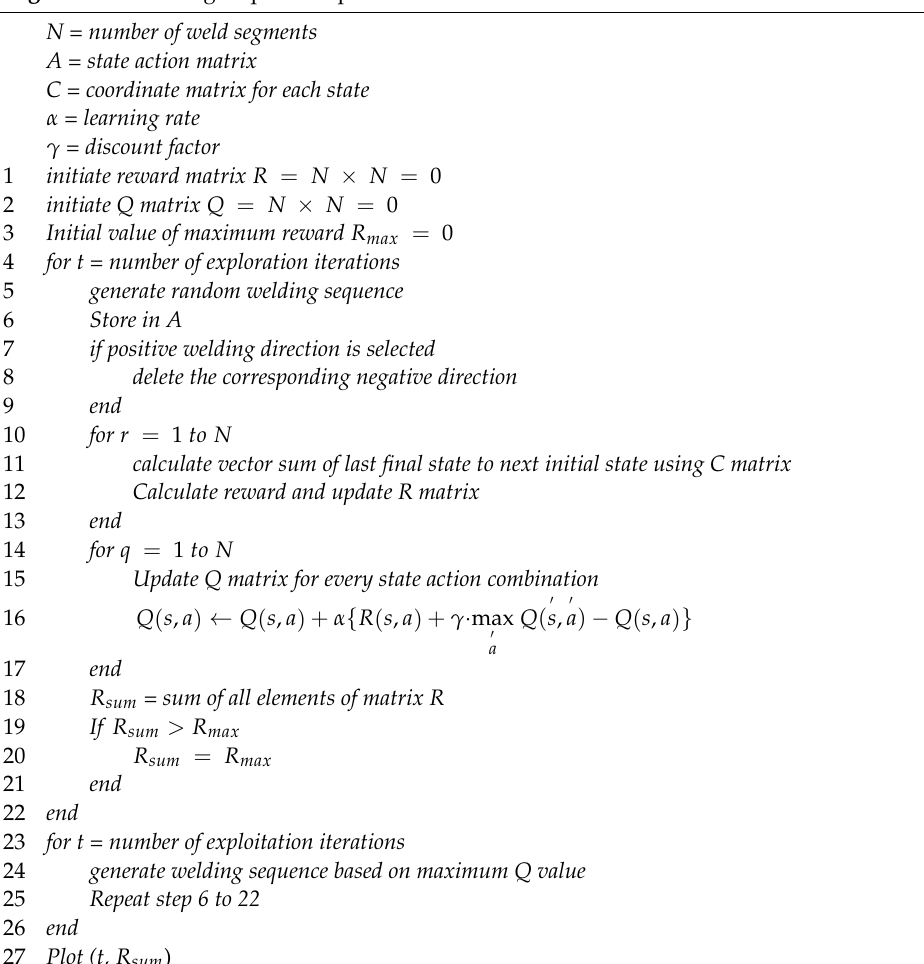
Algorithm 1 Welding Sequence